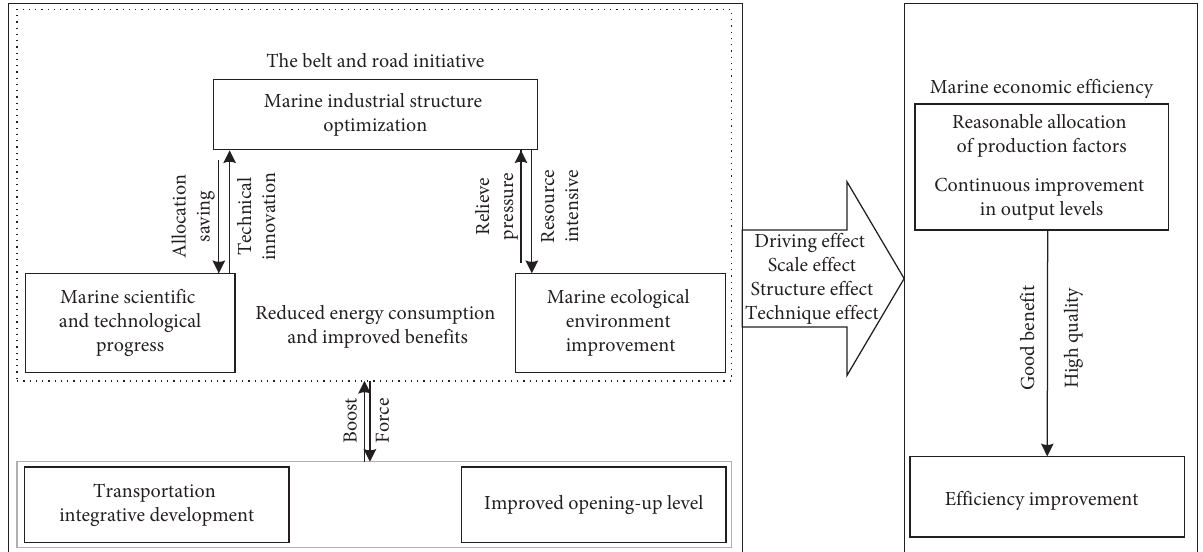
Figure 1: The mechanism of the Belt and Road Initiative on marine economic